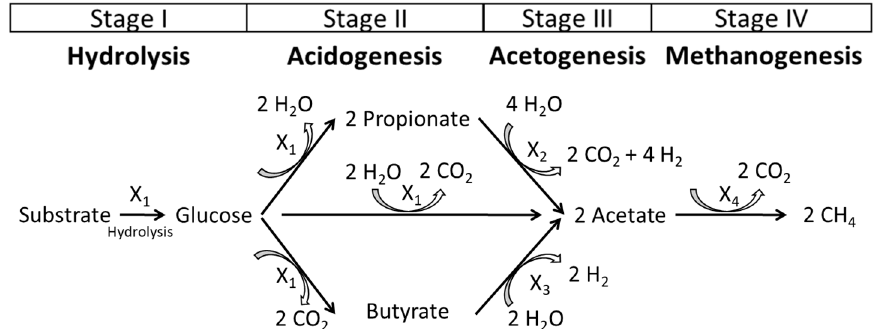
Figure 1. Simplified biochemical model of anaerobic digestion of biomass by the consortium of glucose-fermenting acidogens (X 1 ), propionate-degrading acetogens (X 2 ), butyrate-degrading aceto- gens (X 3 ), and acetoclastic methanogens (X 4 ).